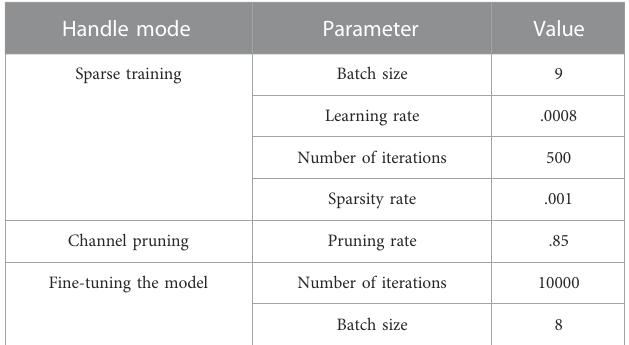
TABLE 3 Parameter setting for channel